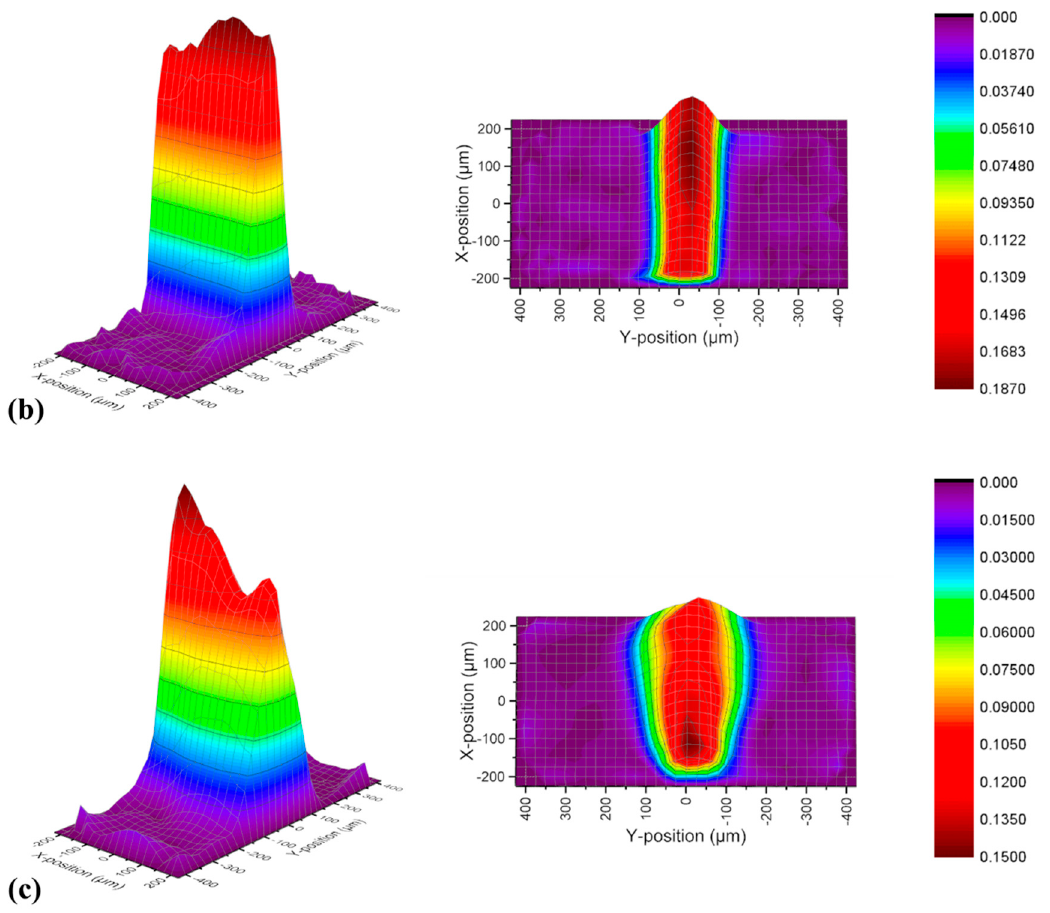
Figure 7. The 3D velocity fields of the ( a ) Newtonian fluid; ( b ) HPAM solution and ( c ) VES fluid in long continuous pore-throat structure at Q = 12 mL/h.